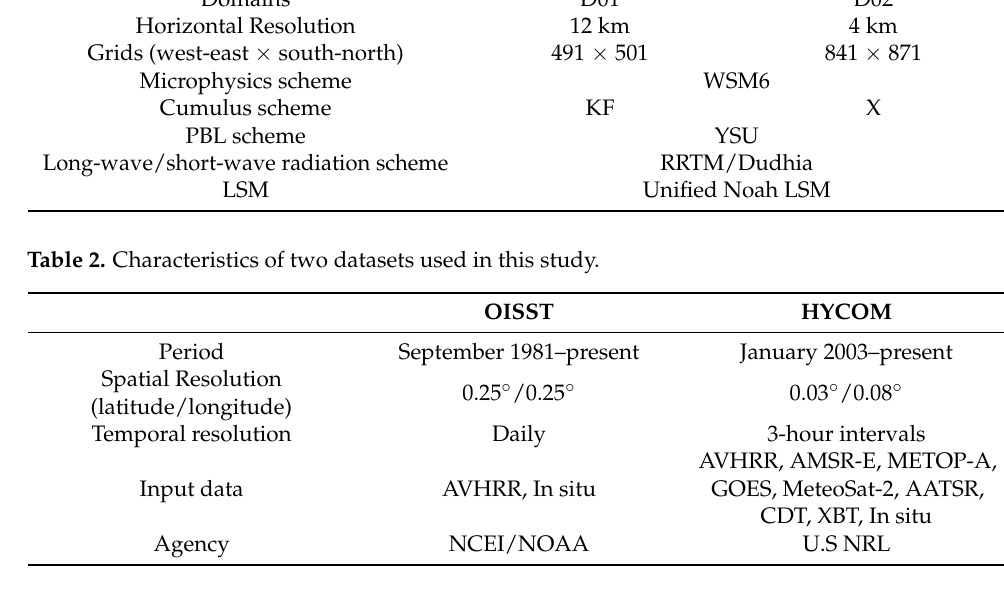
Figure 1. Terrain height (m, shading) and model domains for all the simulations. Typhoon marks represent the Regional Specialized Meteorological Center (RSMC) best tracks of typhoons Maysak and Haishen. Filled and unfilled stars represent the Geomundo and Tongyeong stations at 34.0° N 127.5° E and 34.4° N 128.2° E, respectively. Table 1. WRF model configuration.